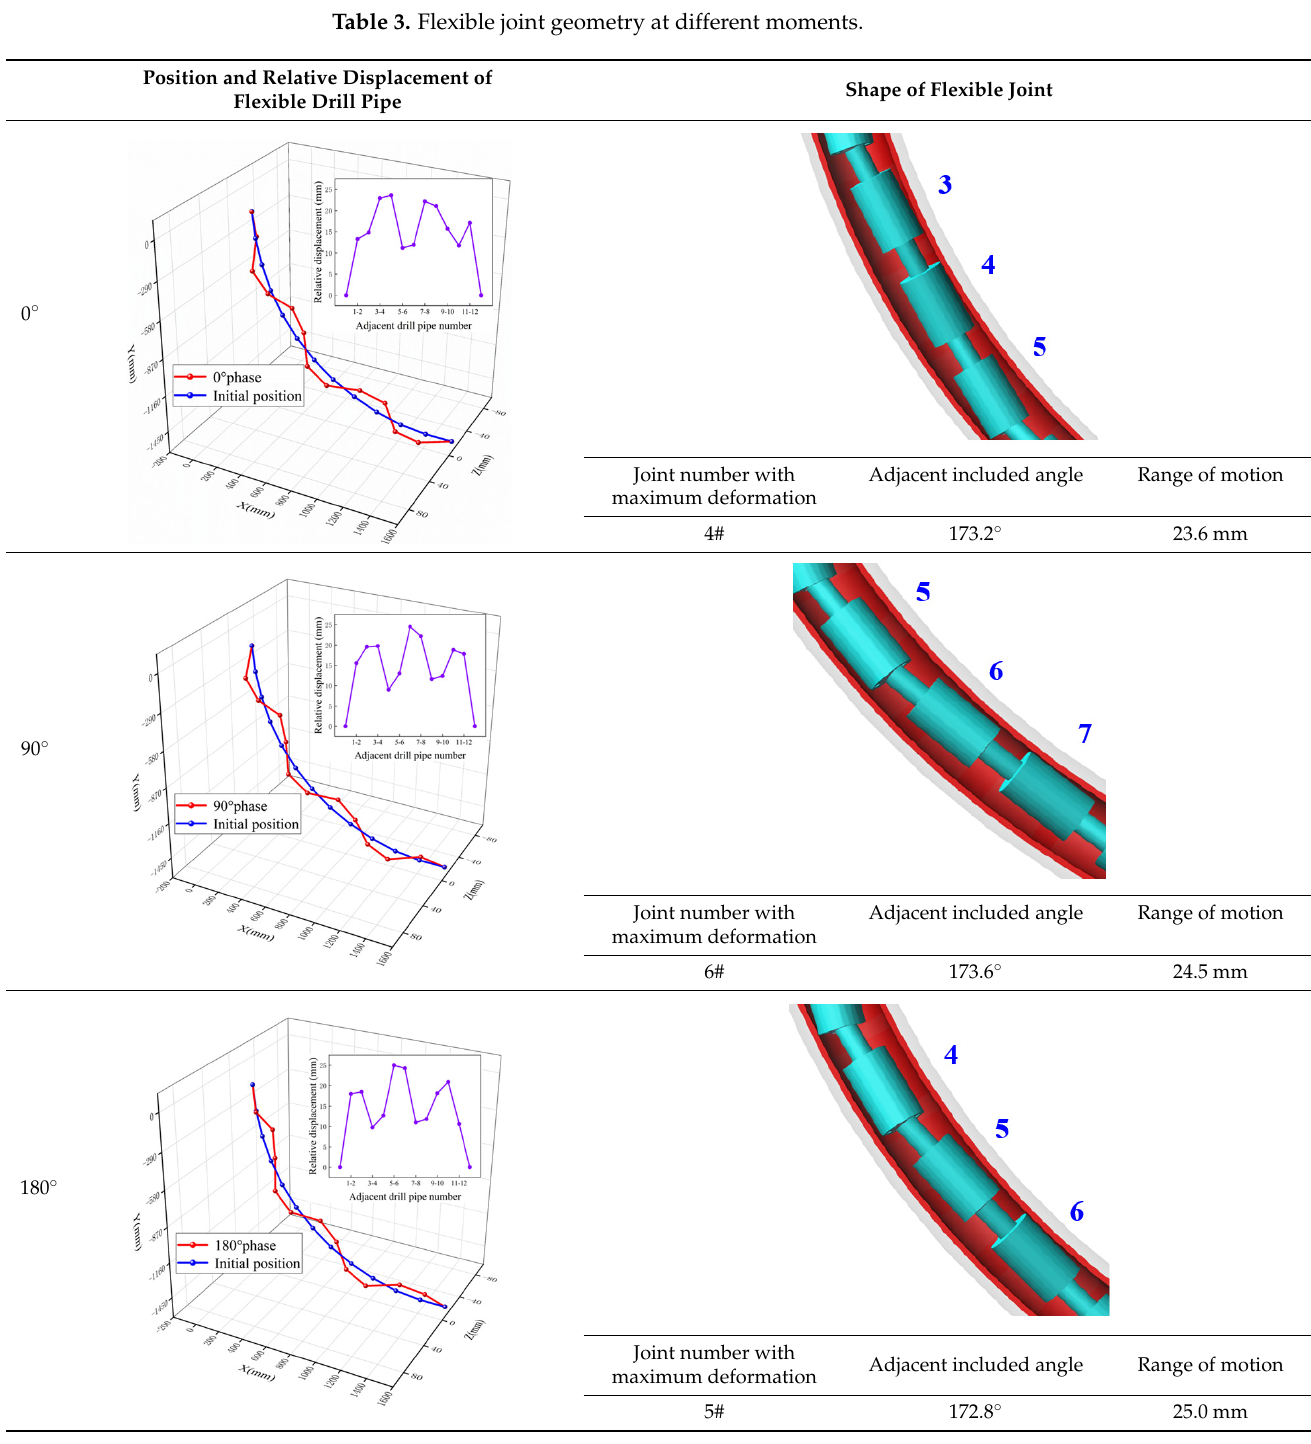
Table 3. Flexible joint geometry at different moments.